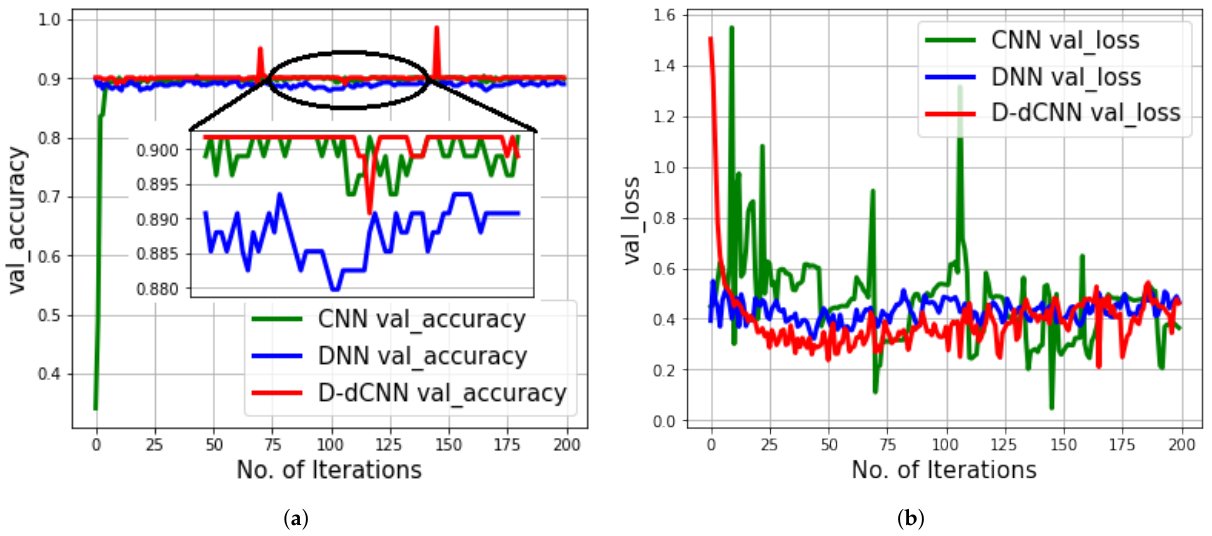
Figure 3. Test/validation progress of proposed model and standalone models over 200 iterations. ( a ) accuracy and ( b )